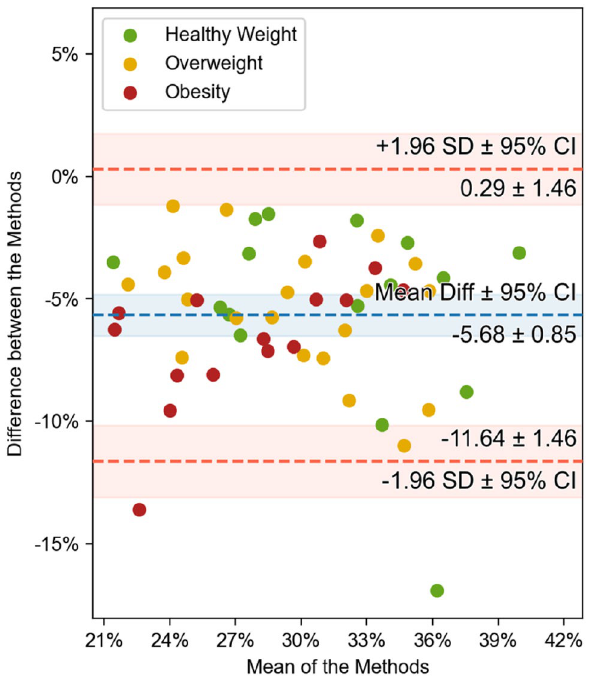
Figure 5. Comparison of SMR between BCA and BIA (N = 52) using Bland–Altman (or mean-difference) plots. Each data point has been colored according to the BMI category of the patient it represents. The mean difference and the limits of agreement are shown in blue and red, respectively, together with their 95% confidence